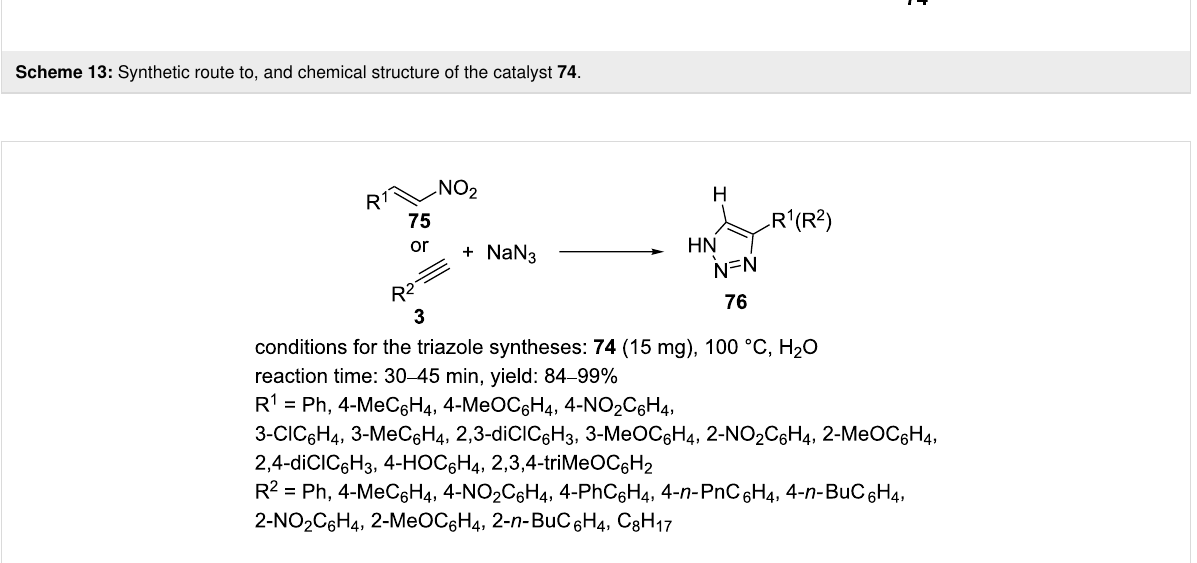
Scheme 14: Application of the cayalyst 74 in “click”